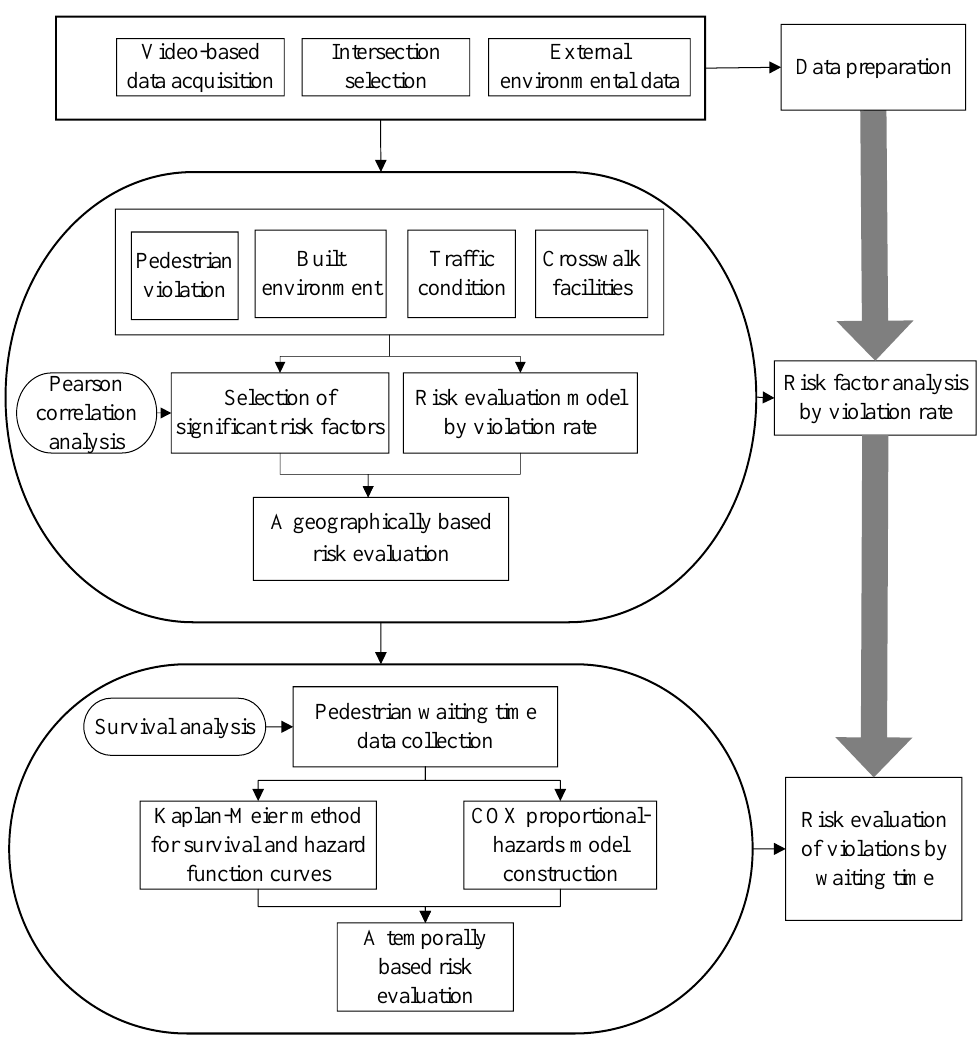
Figure 1. Research framework.